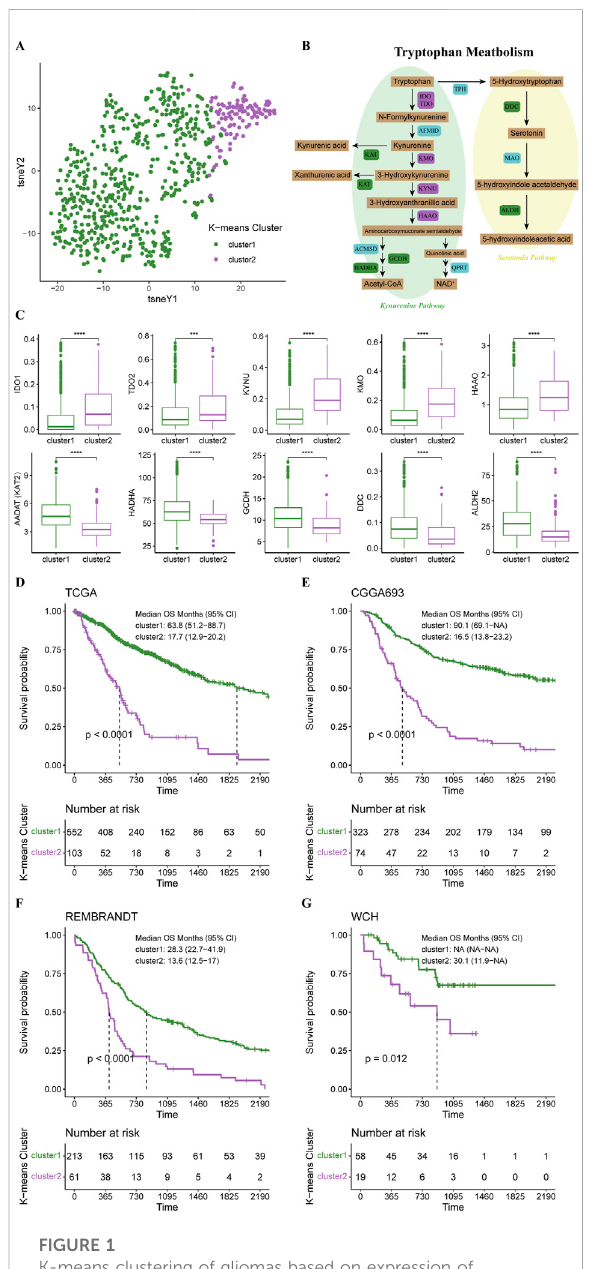
FIGURE 1 K-means clustering of gliomas based on expression of TrMGs. (A) TrMGs expression t-SNE. (B) Schematic diagram for tryptophan metabolism (C) The expression levels of ten important TrMGs between two K-means clusters (cluster 1: N = 556, cluster 2: N = 106). (D) Kaplan-Meier Curve based on K-means clusters in TCGA, (E) CGGA, (F) REMBRANDT, and (G) WCH cohorts.IDO,indoleamine2,3-dioxygenase;TDO,tryptophan2,3- dioxygenase; AFMID, arylformamidase; KMO, kynurenine 3- monooxygenase; KYNU, kynureninase; KAT, kynurenine aminotransferase; HAAO, 3-hydroxyanthranilic acid oxygenase; ACMSD, aminocarboxymuconate semialdehyde decarboxylase; GCDH, glutaryl-CoA dehydrogenase; HADHA, hydroxyacyl-CoA dehydrogenase trifunctional multienzyme complex subunit